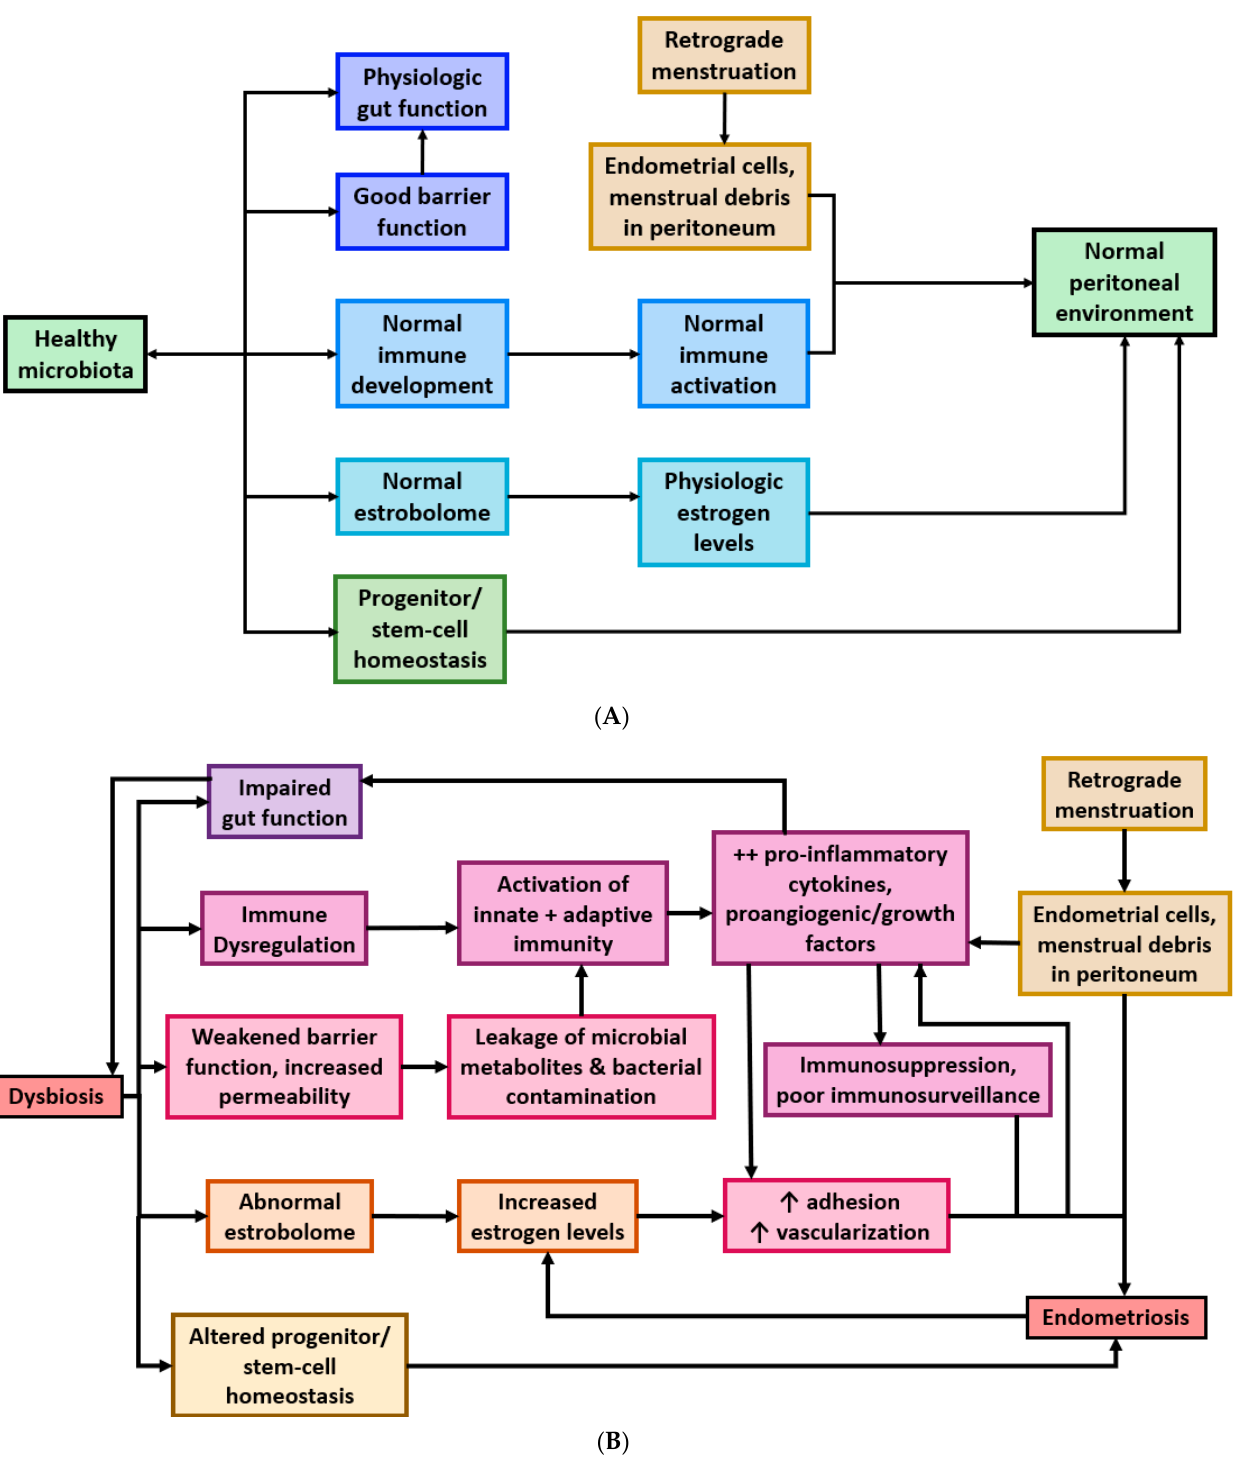
Figure 5. ( A ). The microbiota regulates factors involved in maintaining normal peritoneal environment and ectopic cell clearance. ( B ). Dysbiosis contributes to the dysregulation of factors driving endometriosis onset and progression.